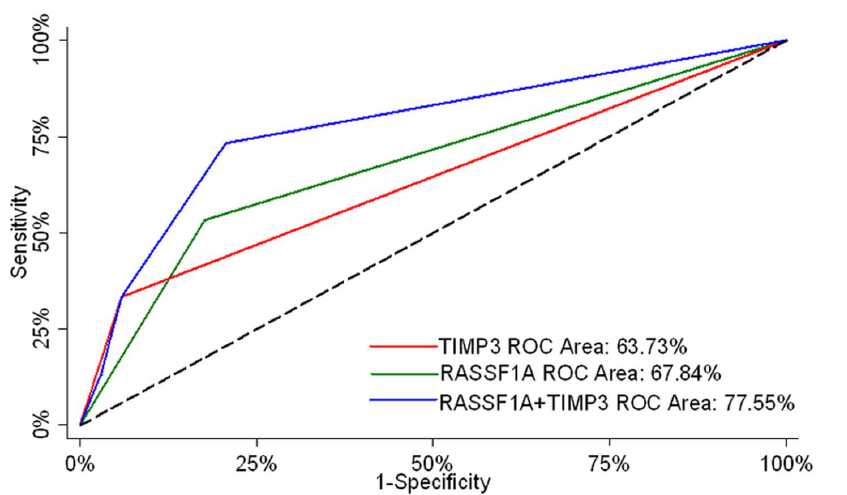
Figure 1. Areas under the receiver operator characteristic curves (AUC-ROC) for the ability of RASSF1A , TIMP3 and combination of RASSF1A and TIMP3 to predict severe bladder damage associated with S.haematobium infection. The AUC- ROC of RASSF1A , TIMP3 and combination of RASSF1A and TIMP3 were 67.84%, 63.73% and 77.55% respectively. doi:10.1371/journal.pone.0059089.g001 PLOS ONE |